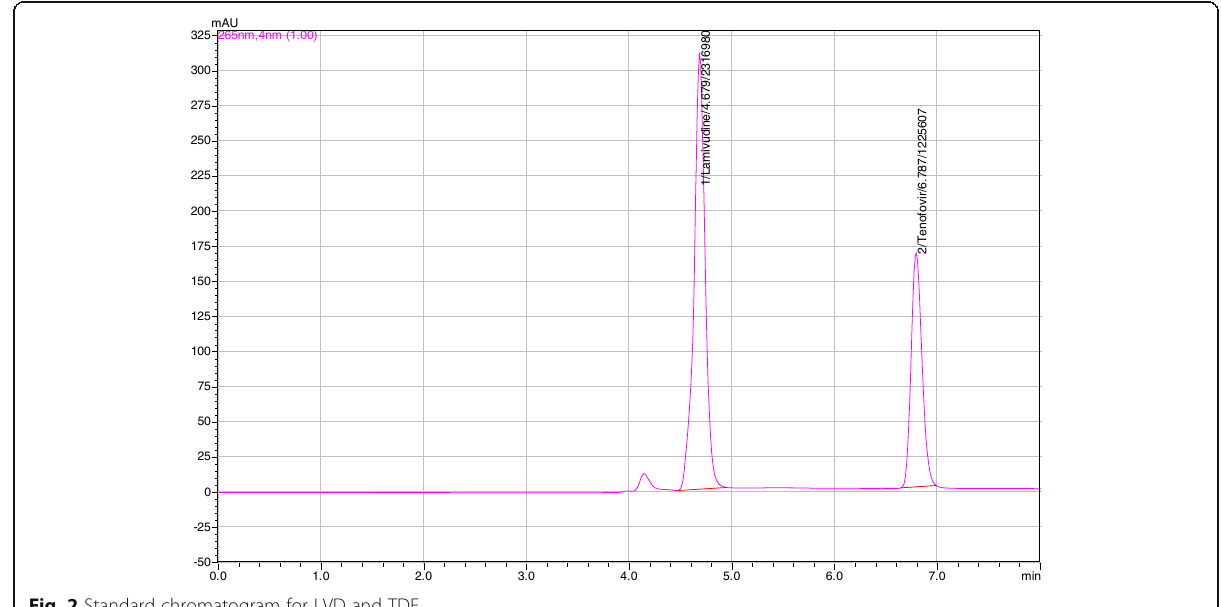
Fig. 2 Standard chromatogram for LVD and